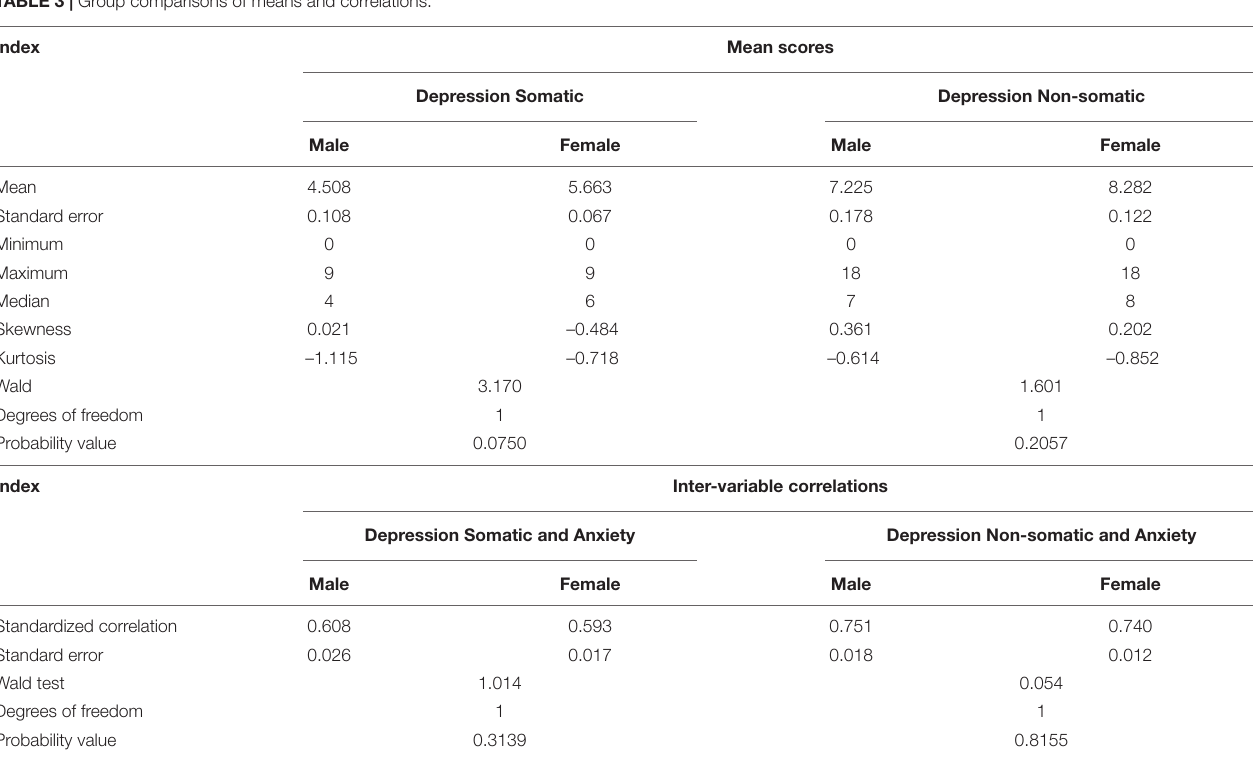
TABLE 3 | Group comparisons of means and